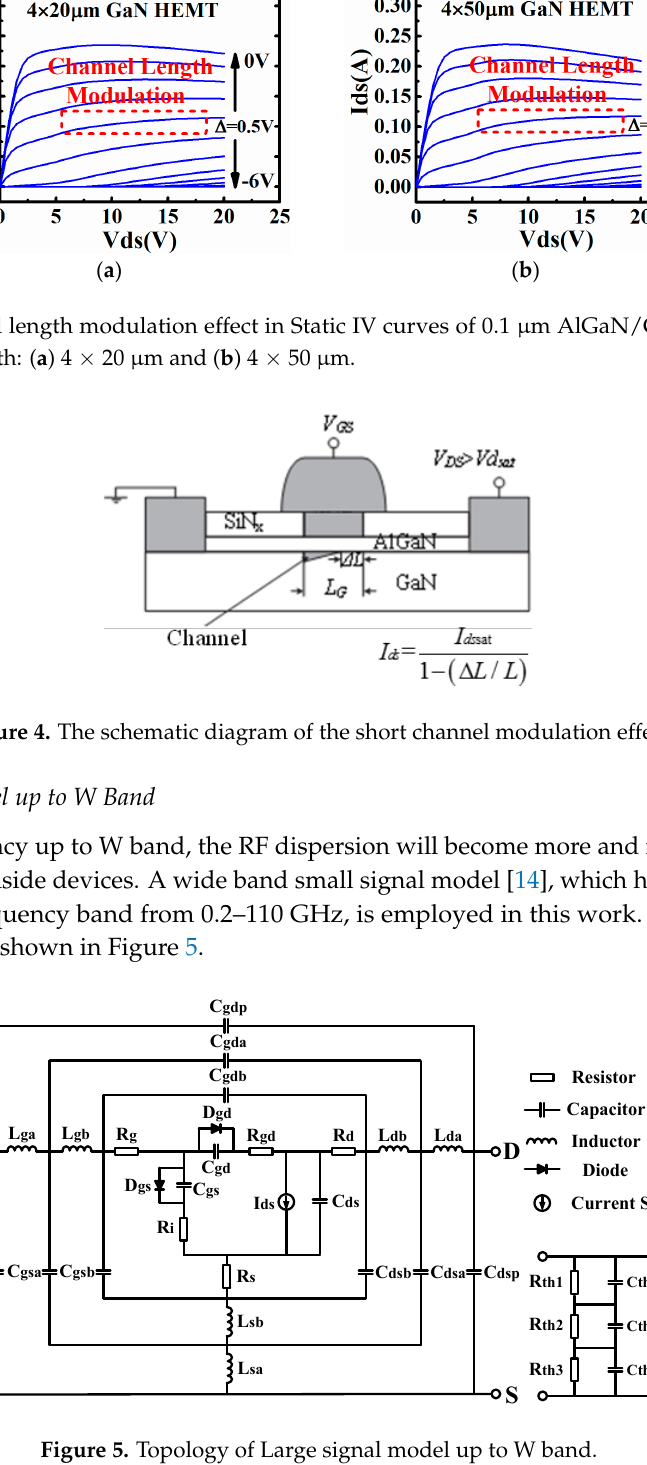
Figure 5. Topology of Large signal model up to W band.